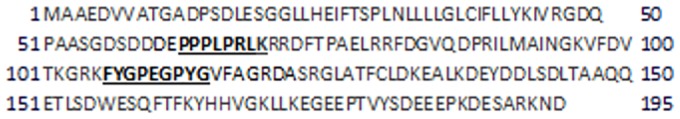
Sequence of human PGRCM1 from Uniprot (O00264).In bold are evidenced the two putative consensus sequences potential target of SH3 domains as obtained by SH3-Hunter web site [50].